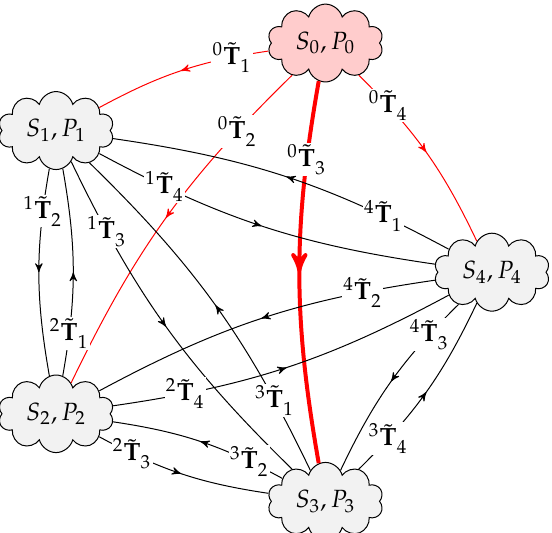
Figure 4. Example of five distinct sensors and their point clouds where all transformation paths from S 0 to S 3 , passing also through S 1 , S 2 , and S 4 , can be established. In the figure, transformations from S 0 to the other sensors are actually the ones who require improved estimates based on the several transformation paths and associated derived transformations, that is, calculate 0 ˆ T n using the several j ˜ T diagram and obtained experimentally. Both i ˜ T technique or, to save time, just by performing algebraic inversion: i ˜ T